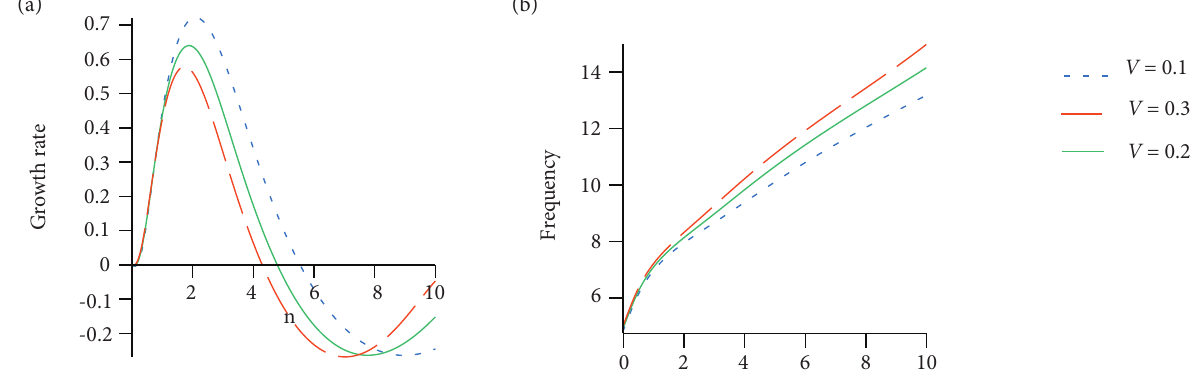
n Figure 16. Thermoacoustic characteristics of a ducted resonator as volume ratio varies (3L mode, τ = 0.6, x